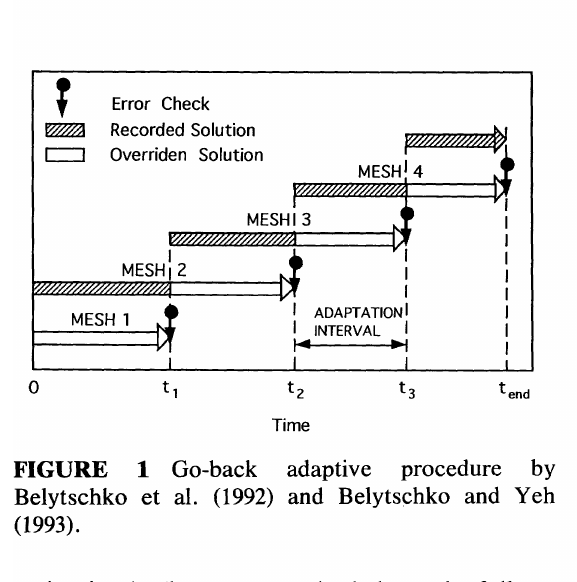
FIGURE 1 Go-back adaptive procedure by Belytschko et al. (1992) and Belytschko and Yeh (1993).